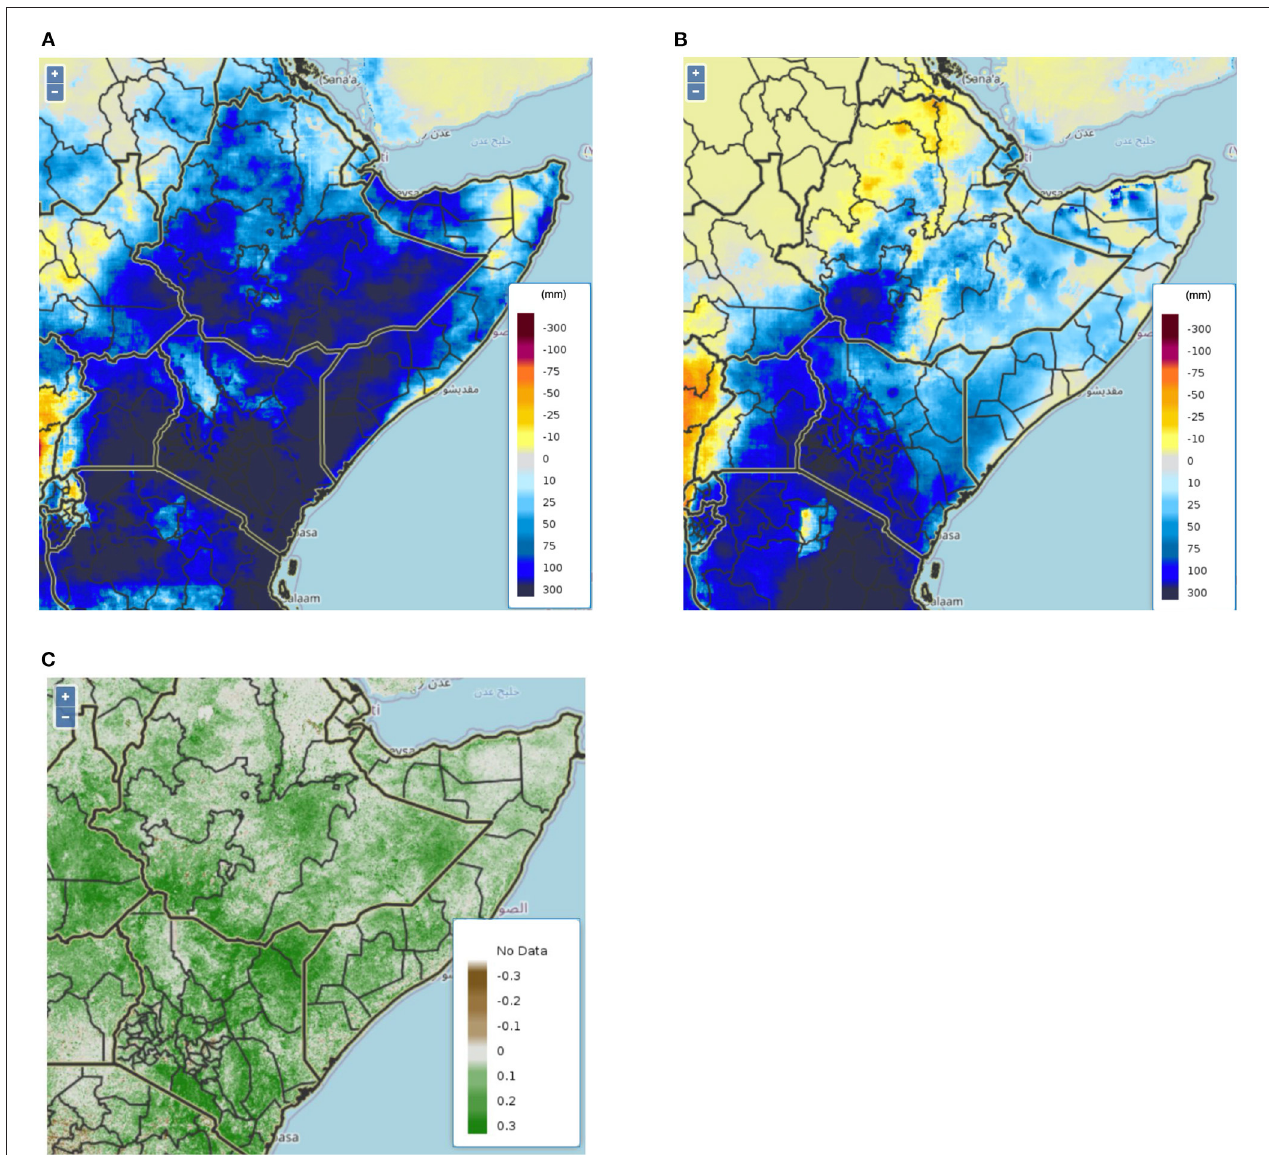
FIGURE 1 | Three month precipitation anomalies derived from the Climate Hazards Group InfraRed Precipitation with Station Data (CHIRPS) for October, November, and December 2019 (A) , and January, February, March 2020 (B) . The region experienced ∼ 50–300 mm more precipitation than average 3-monthly periods leading to enhanced greenness throughout the region (C) showing MODIS derived NDVI anomalies from the second dekad in January